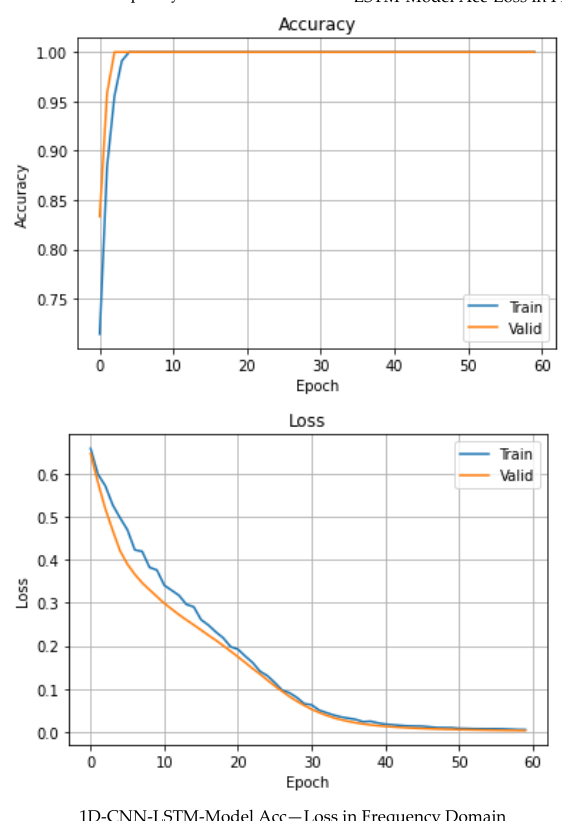
Figure 7. The accuracy and loss curves are shown in the frequency domain for the 1D-CNN, LSTM, and 1D-CNN-LSTM models. In the time domain, 438 samples were generated from simulations to represent arcing and non-arcing conditions, and 70% of these samples were randomly selected for training, while 15% each were used for model validation and testing. The same testing, validation, and training datasets were used for all methods, totaling 306 samples in the training phase. The results of multiple trials were compiled into confusion matrices, which show the accuracy and error rates for each phase. The validation and testing phases contained 66 samples each. In the 1D-CNN-LSTM model training phase, Table 5 shows that, out of the 306 data sets, 272 non-arcing instances and 34 arcing instances were accurately identi- fied, resulting in an accuracy rate of 100% with a 0% error rate. On the other hand, both 1D-CNN and LSTM models detected 260 non-arcing cases and 43 arcing cases with a 99% accuracy rate and a 1% error rate, with three non-arcing cases mistakenly classified as arcing.